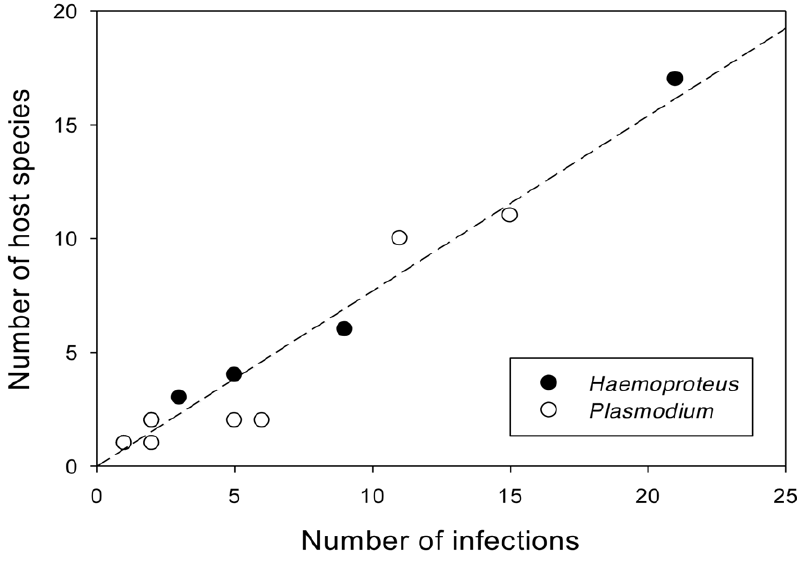
Figure 4. Map illustrating the collection sites in three areas studied (CSP, LSP and UA) in Brazil.